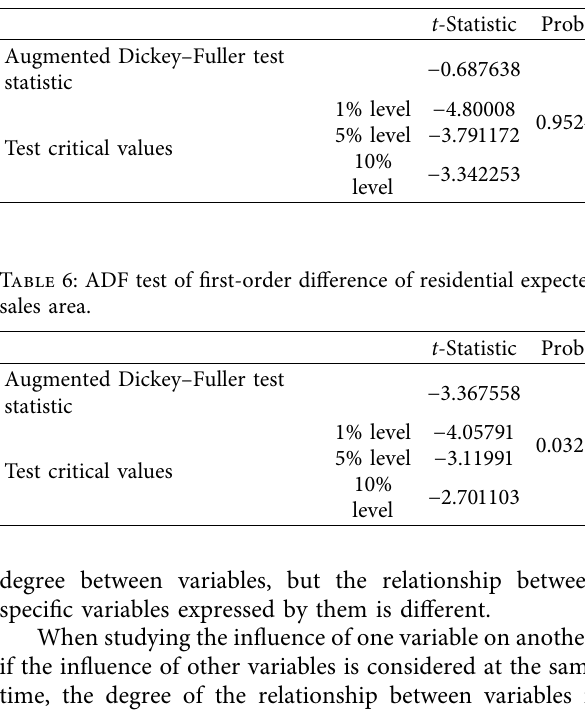
Table 5: ADF test of expected residential sales area.